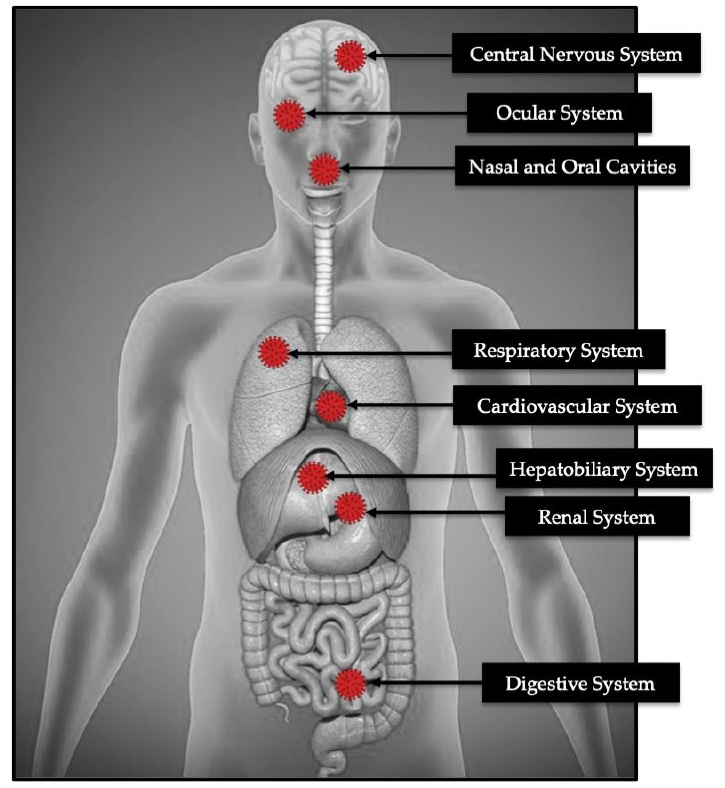
Figure 1. The host sites where COVID-19 spike protein binds to the ACE2.